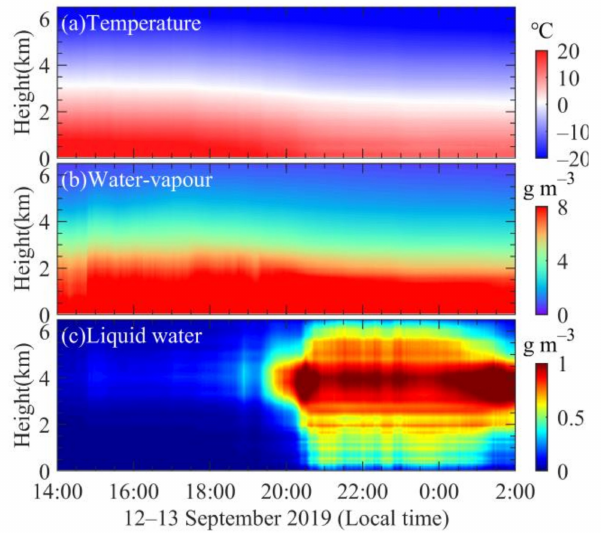
Figure 5. Continuous MWR observation results during 12 − 13 September